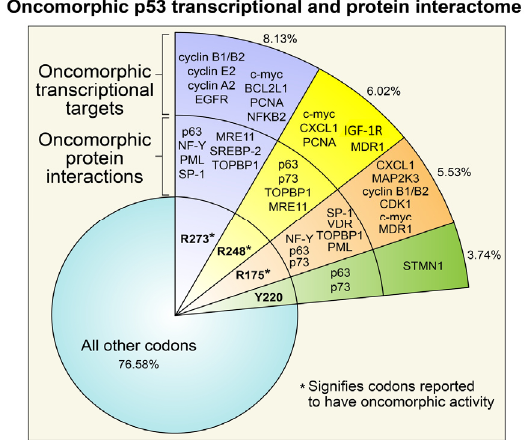
Figure 2. Hotspots for TP53 mutations. Mutations that occur at a frequency greater than 3% are highlighted. Certain p53 mutants have oncomorphic activity (denoted by * ), functioning through novel protein interactions as well as novel transcriptional targets to promote cell survival and potentially chemoresistance. Codons in the “other” category include those that produce non-functional p53 or have not been characterized to